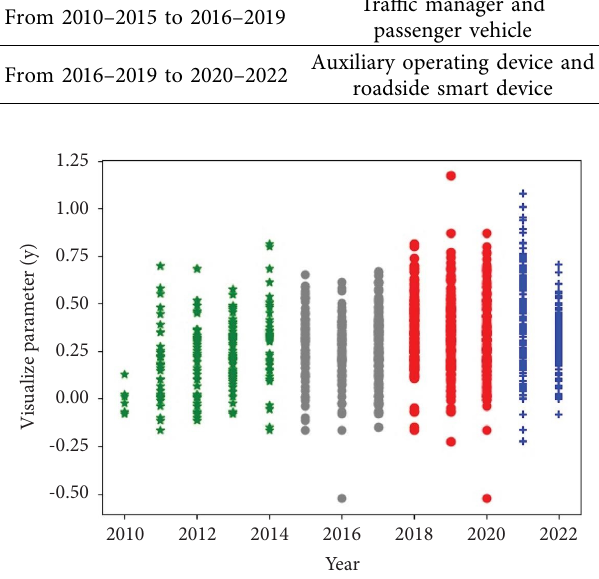
Figure 9: Te clustering result shows that among